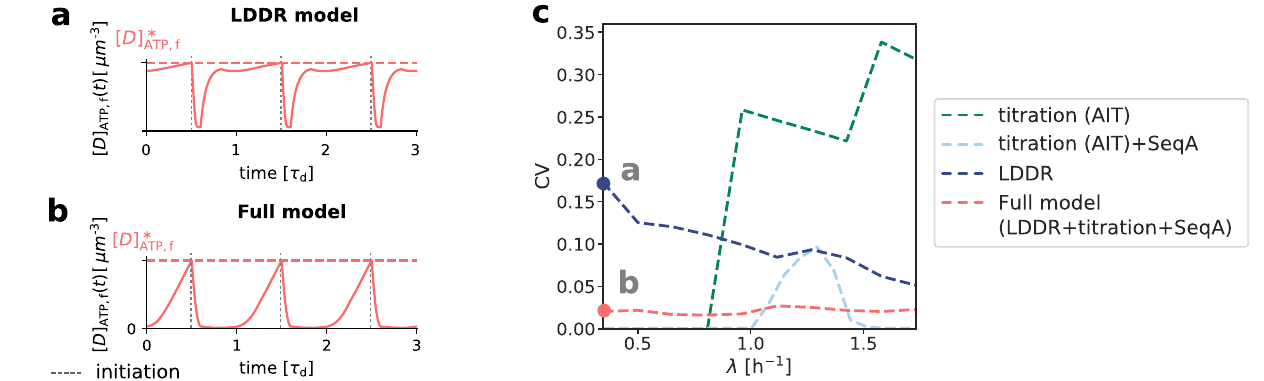
Fig. 5 | Combining the DnaA activation switch with titration and SeqA gen- erates robust replication-initiation cycles over a wide range of growth rates. a , b TheconcentrationoffreeATP-DnaA[ D ] ATP,f ( t )asafunctionoftime(inunitsof the doubling time τ d ) for λ =0.35h − 1 as indicated in panel c. The dashed red line is the critical free ATP-DnaA concentration ½ D (cid:2) * ATP,f at which replication is initiated. While intheLDDR modelthe free ATP-DnaAfractionishighduringalarge fraction of the cell cycle ( a , see also Supplementary Note 3C2), combining it with titration sites and SeqA gives rise to a much sharper increase of the free ATP-DnaA con- centration at low growth rates ( b ). c The coef fi cient of variation CV= σ / μ with the standard deviation σ and the average initiation volume μ = 〈 v * 〉 as a function of